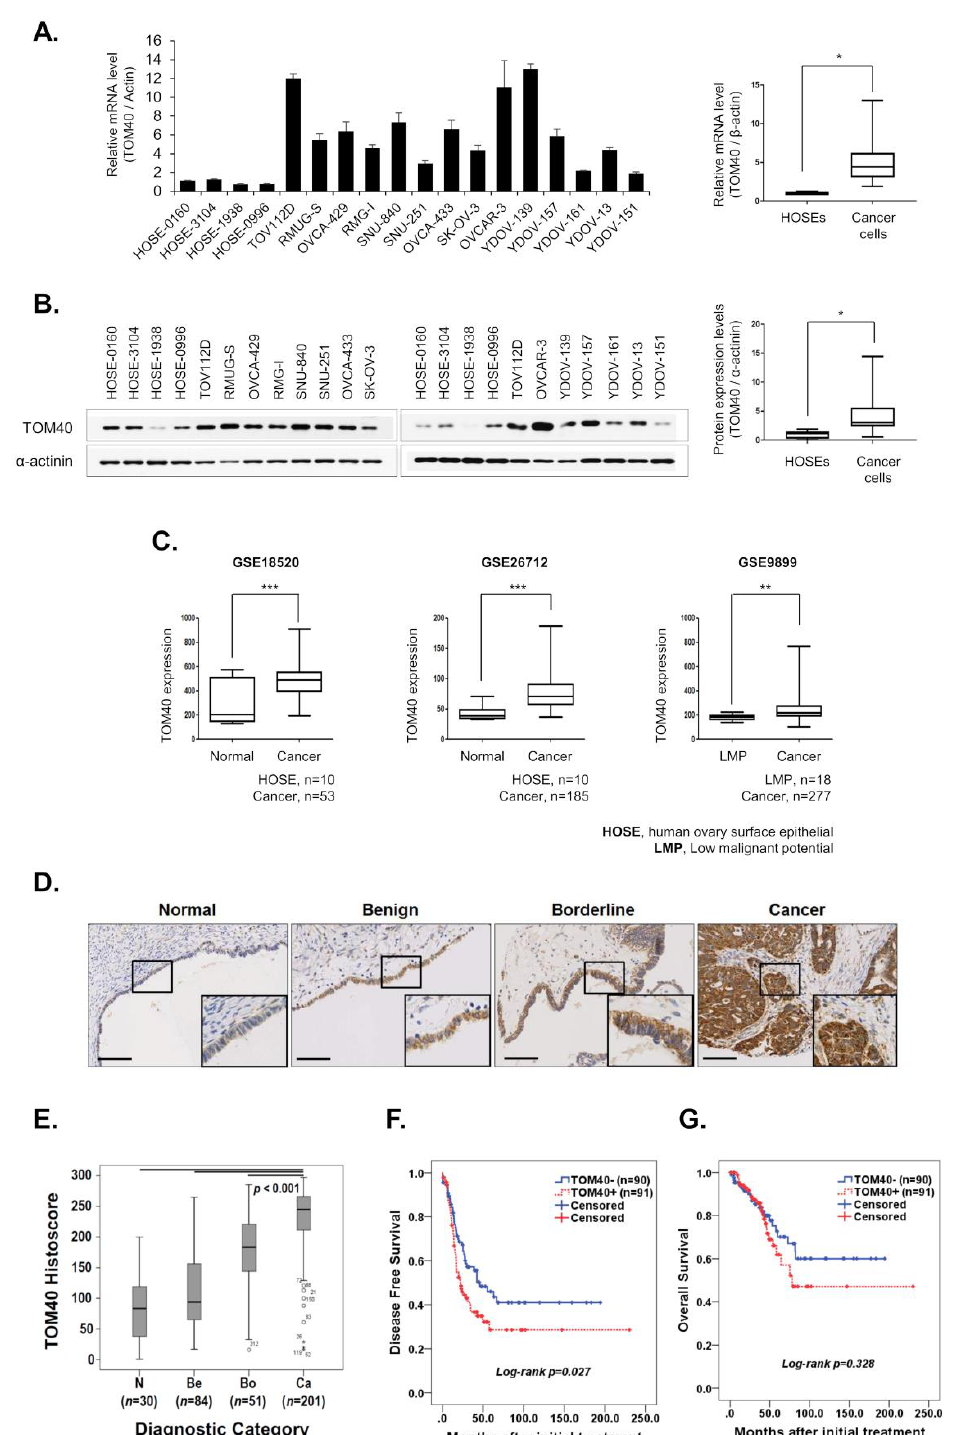
Figure 1. TOM40 is highly expressed by human epithelial ovarian cancer (EOC) cells. ( A ) TOM40 mRNA levels were measured by real-time polymerase chain reaction (PCR) in human ovarian surface epithelial (HOSE) cells and EOC cell lines. Fold expression is expressed as the ratio of TOM40 mRNA/actin mRNA. Results represent the mean ± Standard Error., n = 3. Box plots were used to compare the expression levels of TOM40 in HOSE cells and EOC cell lines; * p < 0.05. ( B ) TOM40 protein expression levels were examined by western blot analysis in HOSE cells and EOC cells. TOM40 band intensities were quantified relative to α-actinin using Image J 1.48v software (Right, box plot); * p < 0.05. ( C ) mRNA